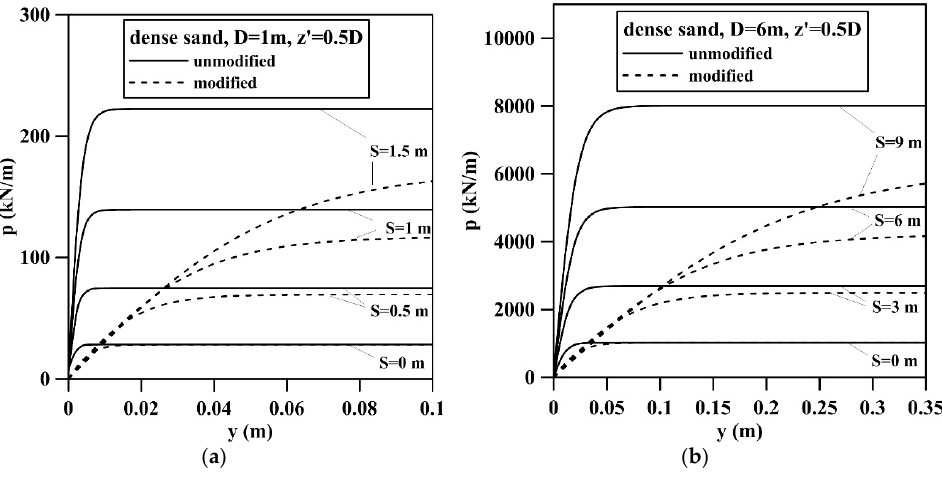
Figure 6. p - y curves for various scour depths at depth of 0.5 D below the bottom of the scour hole. ( a ) D = 1 m; ( b ) D = 6 m.